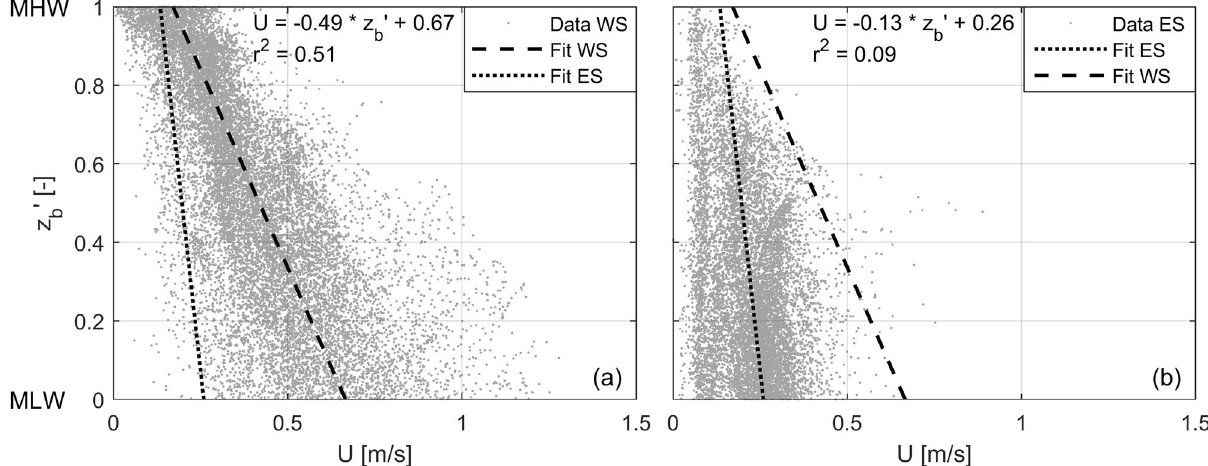
Figure 6. Bed level, scaled along mean low water (MLW; 0) and mean high water (MHW; 1), versus the average peak flow velocity from a 1 month simulation. All points on the intertidal areas of the full ( a ) Western Scheldt (WS) and ( b ) Eastern Scheldt (ES) are shown. Linear fits are provided with coefficients of determination ( r The fits of both estuaries are shown in both graphs to allow